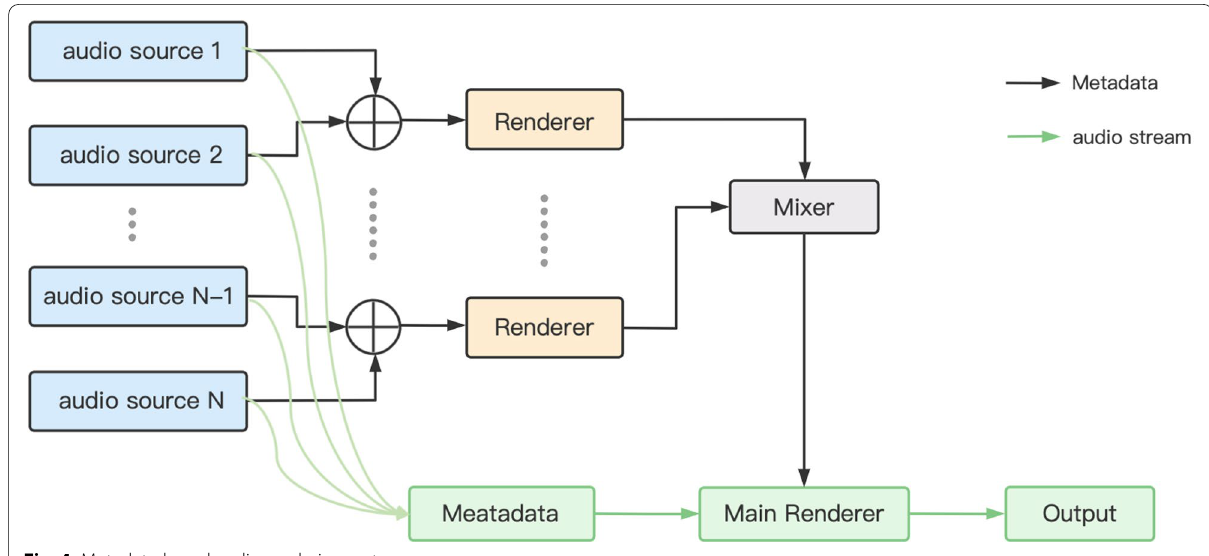
Fig. 4 Metadata-based audio rendering